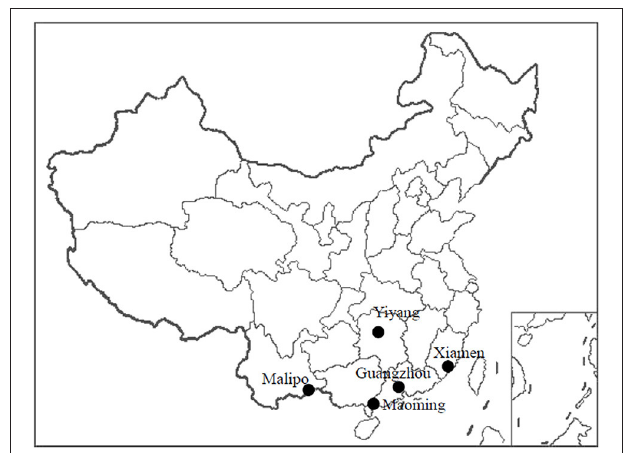
FIGURE 1 | Locations of the animal trapping sites in China. Map source: https ://image.so.com/view?q=%E4%B8%AD%E5%9B%BD%E5%9C%B0%E5%9 B%BE&src=srp&correct=%E4%B8%AD%E5%9B%BD%E5%9C%B0%E5%9 B%BE&ancestor=list&cmsid=50712c46325496ee4c7fbfbded18f06e&cmras= 0&cn=0&gn=0&kn=50&crn=0&bxn=20&fsn=130&cuben=0&pornn=0&manun =50&adstar=0&clw=233#id=812433445ba11b77cba553308beab1d9&currsn